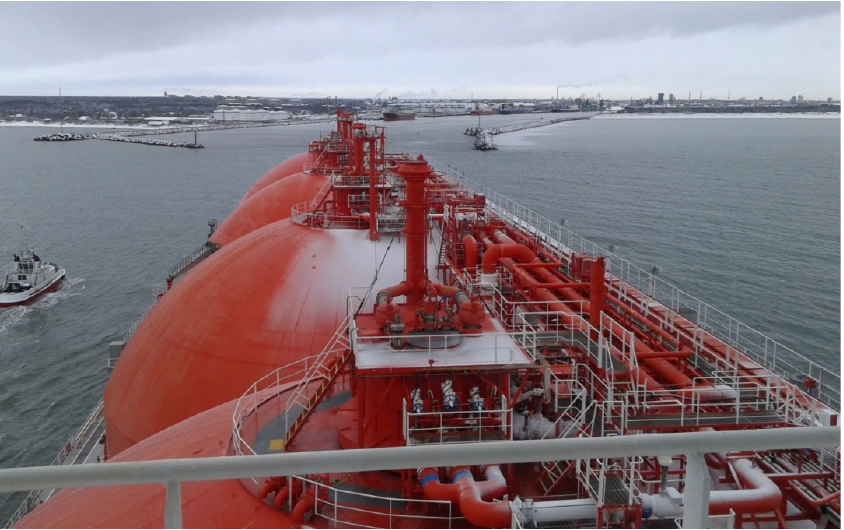
Figure 1. An LNG tanker crossing the approach channel bend close to Klaipeda port gate (own picture).